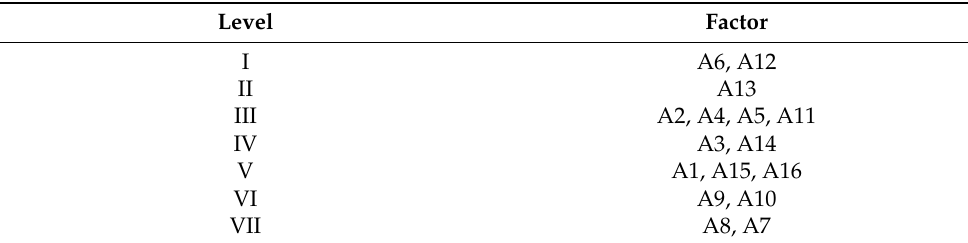
Table 8. Determination of the Factor